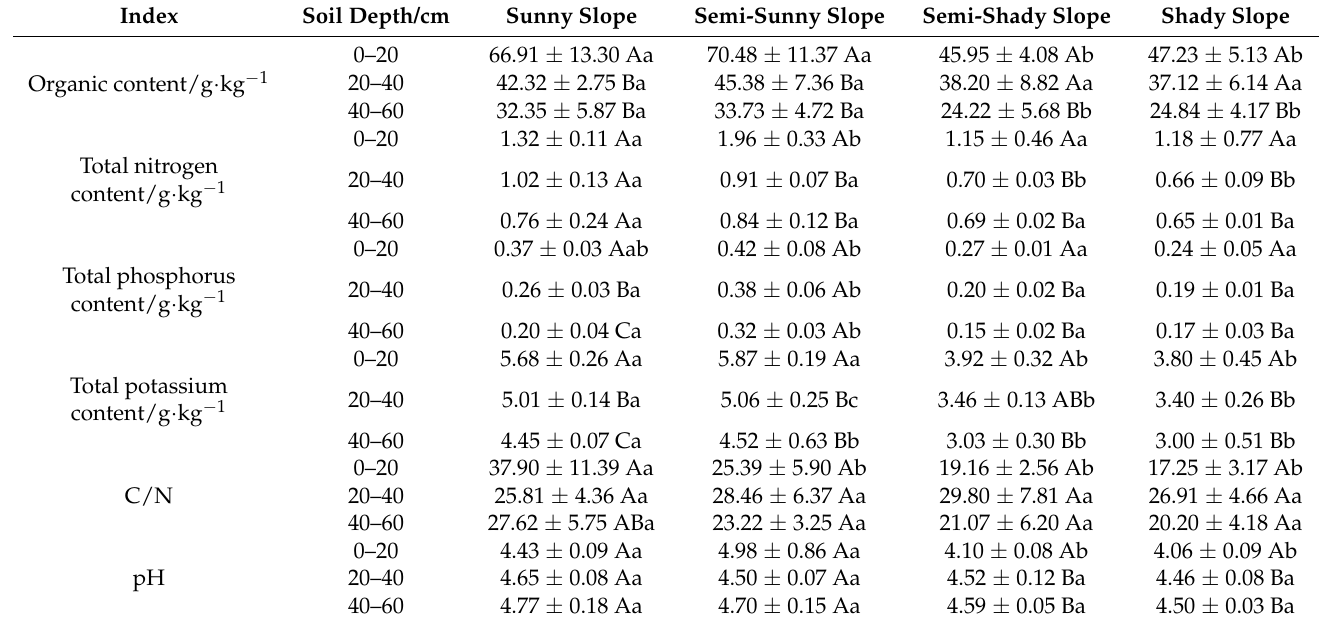
Table 1. Nutrient content, C/N ratio and pH value of different soil layers of Castanopsis hystrix forests on different slope directions.